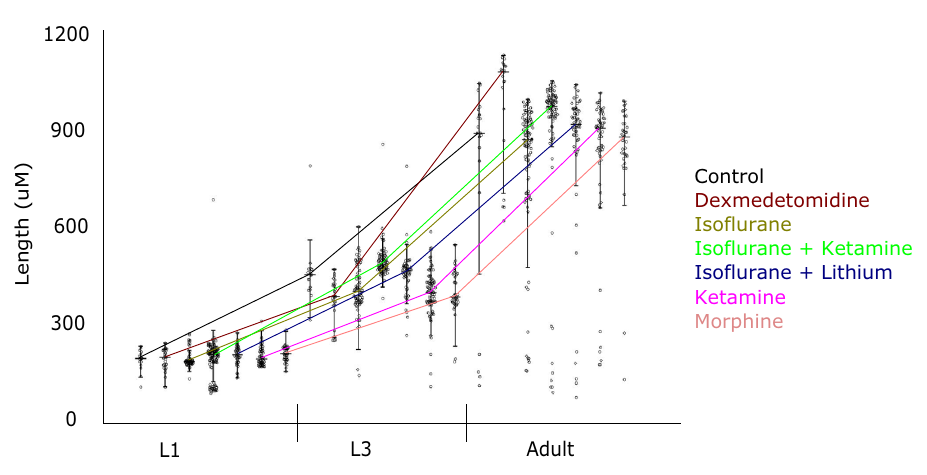
Figure 2. Early administration of anaesthetics has no gross effects on growth but can have long term effects on behaviour. ( a ) Lengths at late-L1, mid-L3, and adult stages. Results for different drug concentrations are pooled. Boxplots given distribution of lengths, with individual data points overlain (each point is the average value for one worm trajectory). Coloured lines represent experimental condition, and connect median lengths at each stage. Growth is as expected, and there are no significant differences in adult size. Analysis of variation (ANOVA) of adult lengths supports the null hypothesis, that population means are equal (F 1.44 < Fcrit